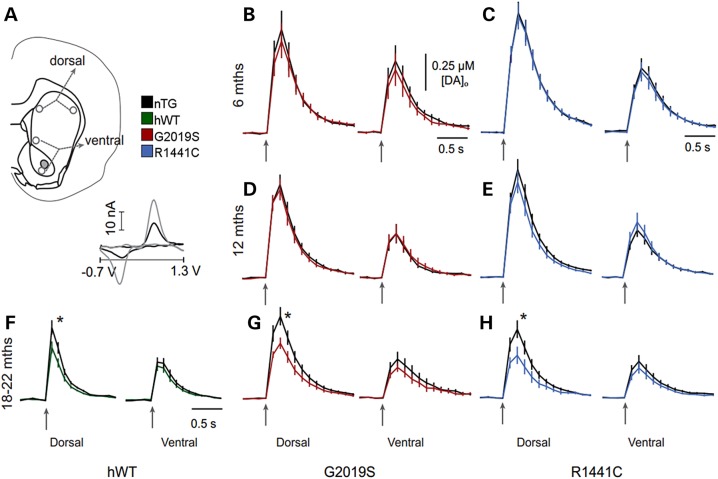
LRRK2 transgenic rats develop late-stage dopamine transmission deficits in the dorsal striatum. (A) Schematic of recording site locations in striatal slices from R1441C, G2019S, hWT and nTG rats. Representative cyclic voltammogram (inset) recorded in striatal tissue (black line) shows peaks at the same oxidation and reduction potentials as a 2 µM dopamine calibration voltammogram (grey line). (B–H) Mean [DA]o profiles versus time following single pulse stimulation (↑200 µs, 600 µA) in dorsal (left panel) or ventral striatum (right panel) of (B, C) 6-month-old G2019S and R1441C rats, (D, E) 12-month-old G2019S and R1441C rats and (F–H) 18- to 22-month-old hWT, G2019S and R1441C rats. Mean peak evoked [DA]o was not significantly different between R1441C rats and nTG controls in either dorsal or ventral striatum at 6 and 12 months of age (P > 0.05; unpaired two-tailed Mann–Whitney; n = 15–29); however, at 18–21 months, mean peak evoked [DA]o was significantly lower in R1441C (0.30 ± 0.06 µM) compared with nTG rats (0.49 ± 0.06 µM) in dorsal striatum (*P < 0.05; unpaired two-tailed Mann–Whitney test; n = 15) but not ventral striatum (P > 0.05; unpaired two-tailed Mann–Whitney test; n = 12). Mean peak evoked [DA]o was not significantly different between G2019S rats and nTG controls in either dorsal or ventral striatum at 6 and 12 months of age (P > 0.05; unpaired two-tailed Mann–Whitney test; n = 11–21); however, at 18–21 months, mean peak evoked [DA]o was significantly lower in G2019S rats (0.40 ± 0.04 µM) compared with nTG controls (0.59 ± 0.07 µM) in dorsal striatum (*P < 0.05; unpaired two-tailed Mann–Whitney test; n = 36) but not ventral striatum (P > 0.05; unpaired two-tailed Mann–Whitney test; n = 25). At 22 months, mean peak evoked [DA]o was significantly lower in LRRK2 hWT rats (0.27 ± 0.03 µM) compared with nTG controls (0.37 ± 0.04 µM) in dorsal striatum (*P < 0.05; unpaired two-tailed Mann–Whitney test; n = 30) but not ventral striatum (P > 0.05; unpaired two-tailed Mann–Whitney test; n = 29–30). Data are expressed as mean ± SEM. Comparison of falling phases of mean dopamine release transients from CPu of 18- to 22-month-old nTG and LRRK2 transgenic rats reveals no significant difference (one-phase exponential decay curve fits; P > 0.05, n = 15–35, K = 2.94–2.97 s−1 nTG K = 2.82–3.19 s−1 LRRK2 transgenics), suggesting no difference in reuptake rate of dopamine between genotypes.